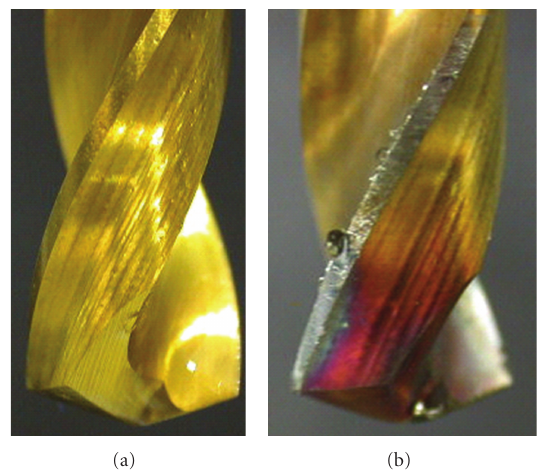
Figure 3: (a) Drilling tool as received. (b) Drilling tool after drilling five holes at 30 m/min.